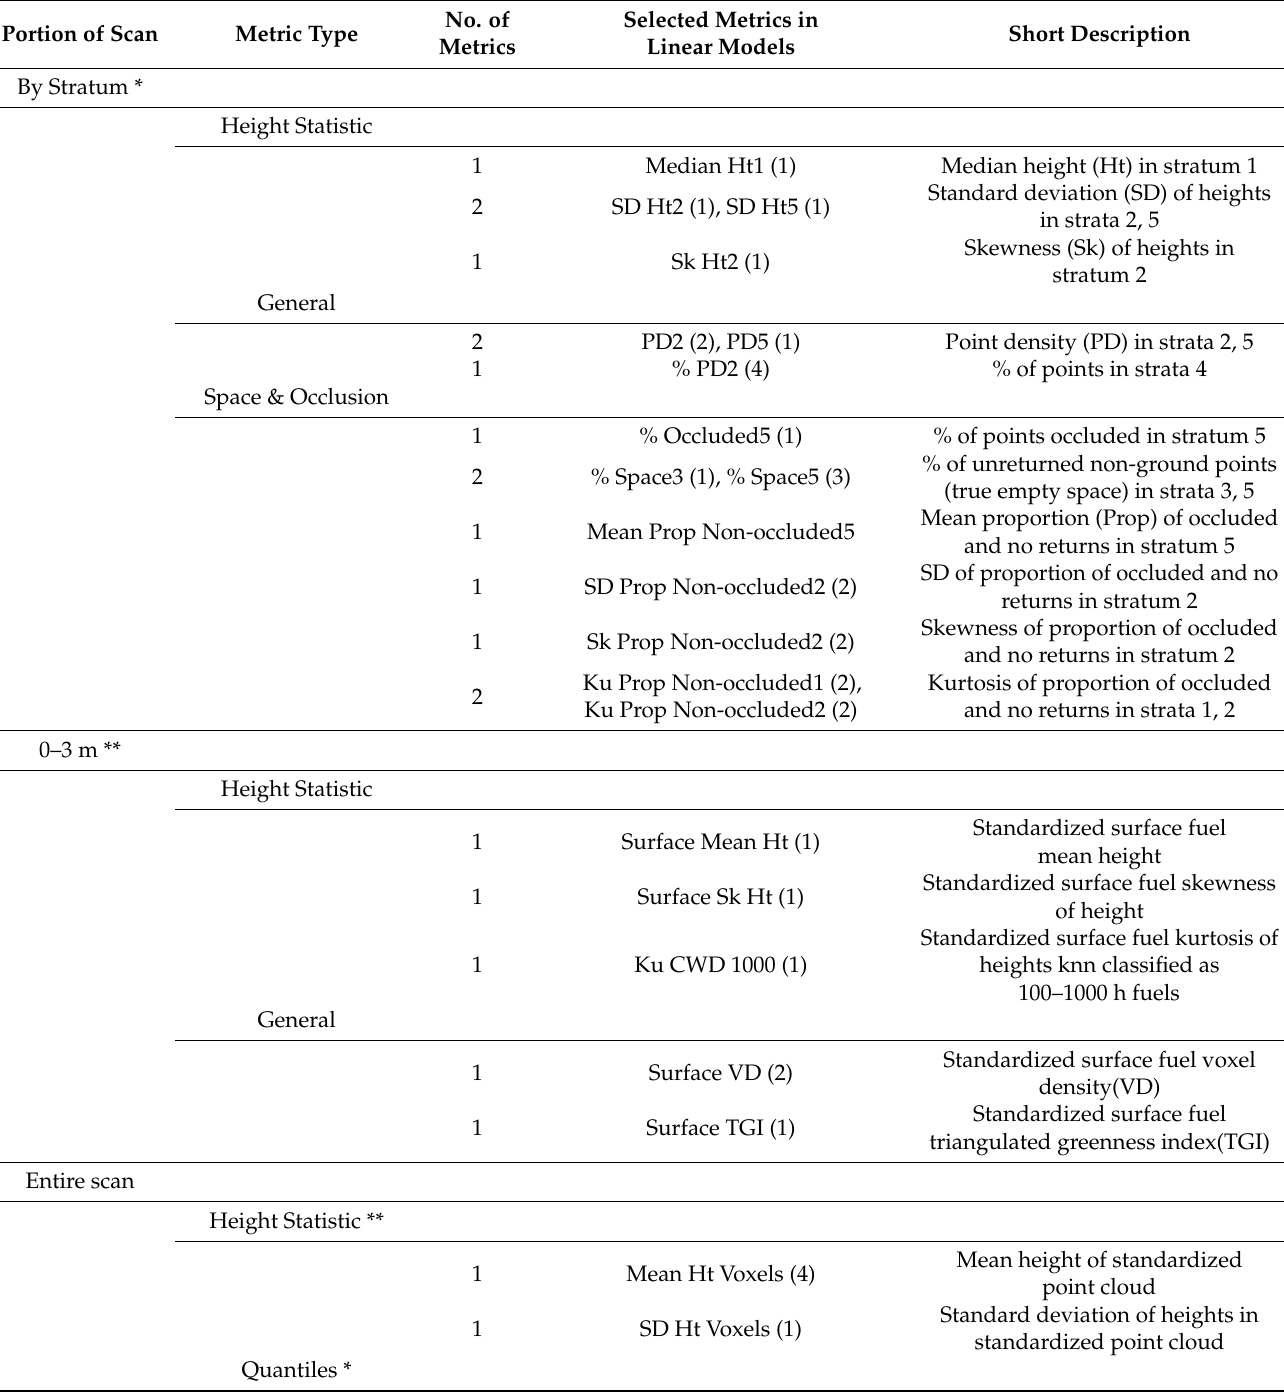
Table 2. Selected metrics from linear models illustrating the portion of the scan in which the metric was derived, the metric type, as well as the description of each metric. Stratum refers to the height layer within each scan in which the metric was derived, i.e., stratum 1: 0–0.5 m, 2: 0.5–1 m, 3: 1–1.5 m, 4: 1.5–2 m, and 5: >2 m. The numbers in parentheses refer to the number of times that particular metric was selected across the eight linear models in this study. Metric type refers to either a height statistic, general or standard TLS metric (e.g., point density), metric by quantiles, or identified tree structures within each scan. A more detailed description of all metrics is found in Appendix